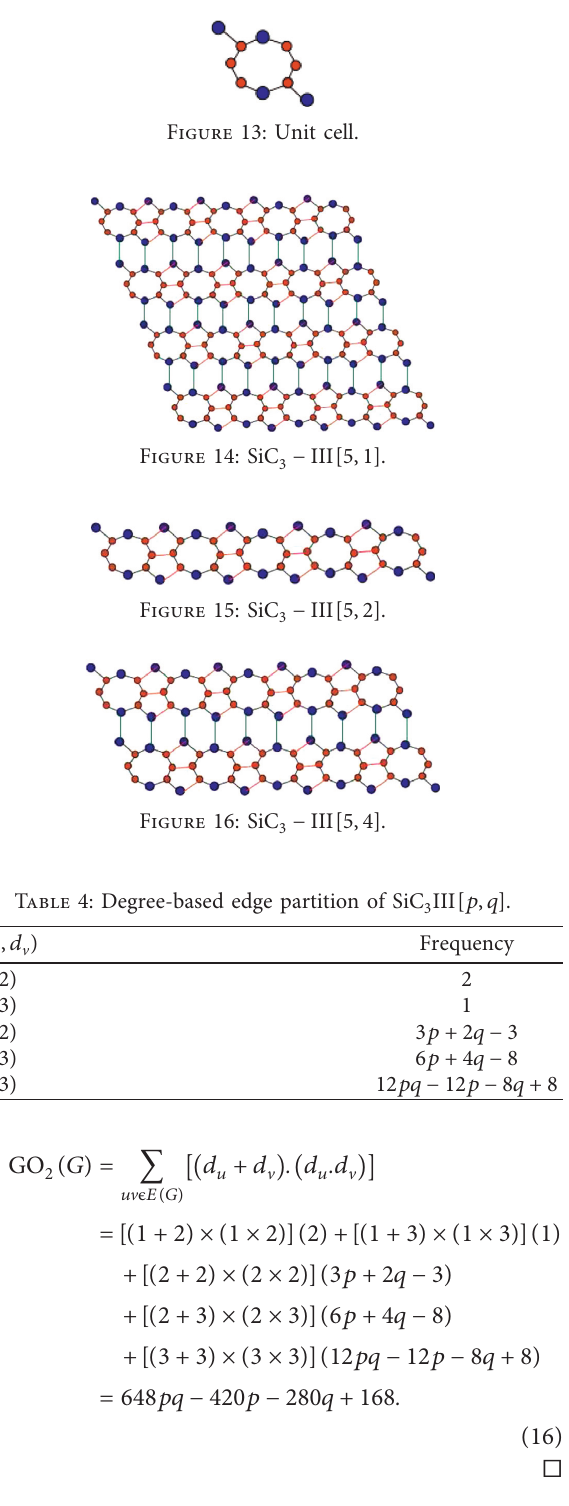
Figure 13: Unit cell.